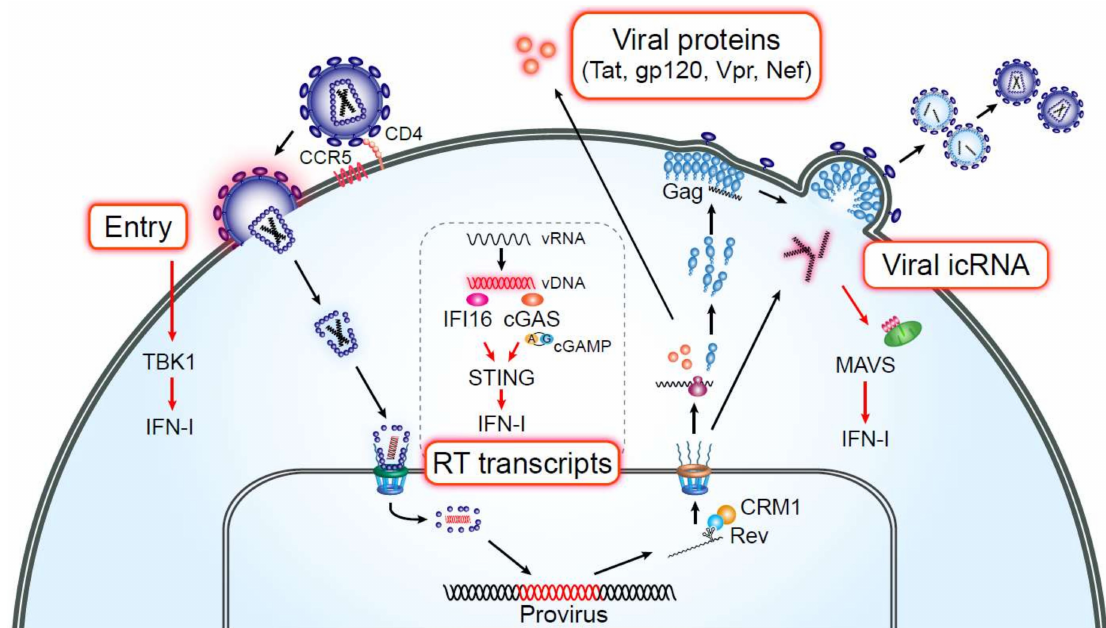
Figure 1. HIV PAMPs in macrophages. Multiple steps of the HIV-1 life cycle are detected by pathogen sensing mechanisms in macrophages. HIV-1 fusion and entry [88], over-exuberant expression of HIV-1 RT transcripts (upon SAMHD1 antagonism) [90,91] and de novo expression and Rev–CRM1-dependent nuclear export of HIV icRNA to the cytosol [98] can all lead to induction of ISG expression and IFN-I responses. Exposure to soluble viral proteins can activate tissue-resident macrophages, such as microglia (reviewed in [72]), resulting in secretion of pro-inflammatory